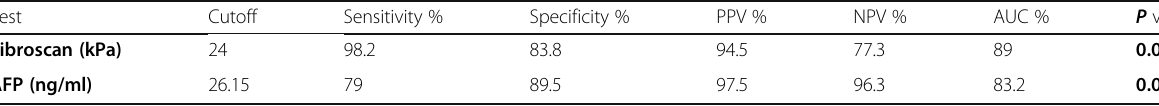
Table 5 Fibroscan and AFP cutoff values as markers for